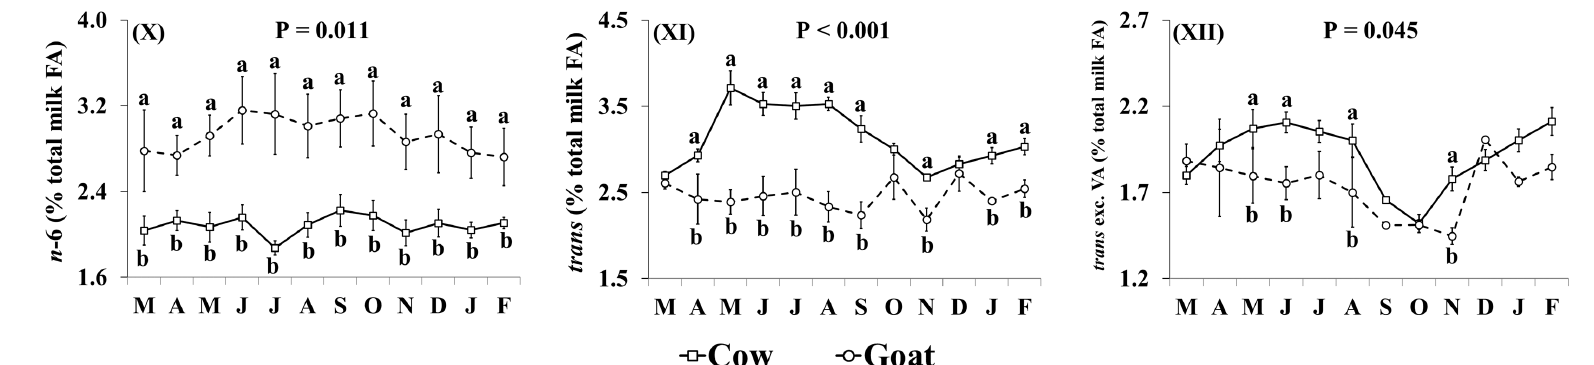
Figure 3. Interaction means ± SE (error bars) for the e ff ects of species (cow, goat) and month (in order of appearance from left to right in Axis X: M, March; A, April; M, May; J, June; J, July; A, August; S, September; O, October; N, November; D, December; J, January; F, February) on the fatty acid (FA) group profile of retail milk: ANOVA p -value for the interaction. Means for species and within a month with di ff erent lowercase letters are significantly di ff erent according to Fisher’s Least Significant Di ff erence test ( p <